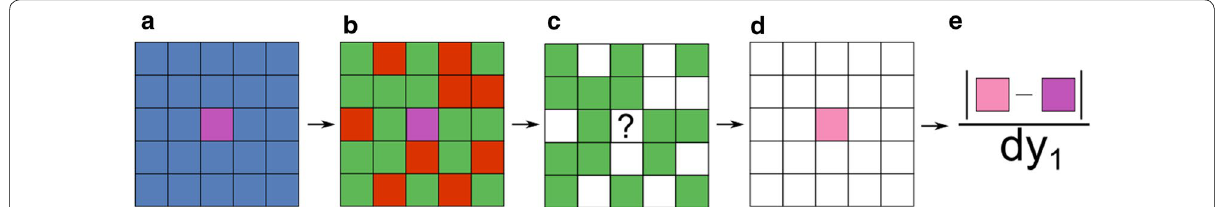
Fig. 3 Reproduced from Dolman and Reid (2014). Graphical representation of the quality control process for a point within its local neighborhood. Part a shows a maximum neighborhood (blue) of 24 points surrounding point x (purple). Part b shows the points which were deemed ‘good’ (green) and ‘bad’ (red). In c only the good points are used in a planar interpolation, to produce an interpolated value of point x ( d ). The original and interpolated values of point x are then used to determine whether x should be considered good or bad ( e